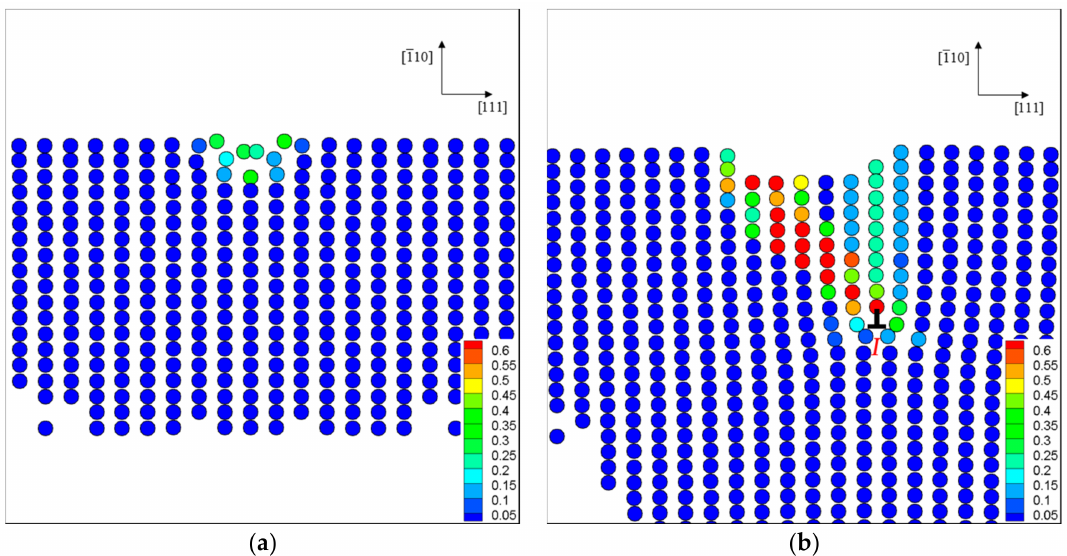
Figure 6. Strain distribution and atom configurations of Al bulk material under the wedged indenter with half vertex angle of 60 ◦ after retractions at A 1 ’ and D 1 ’: ( a ) U 1-1 ; ( b ) U 1-2